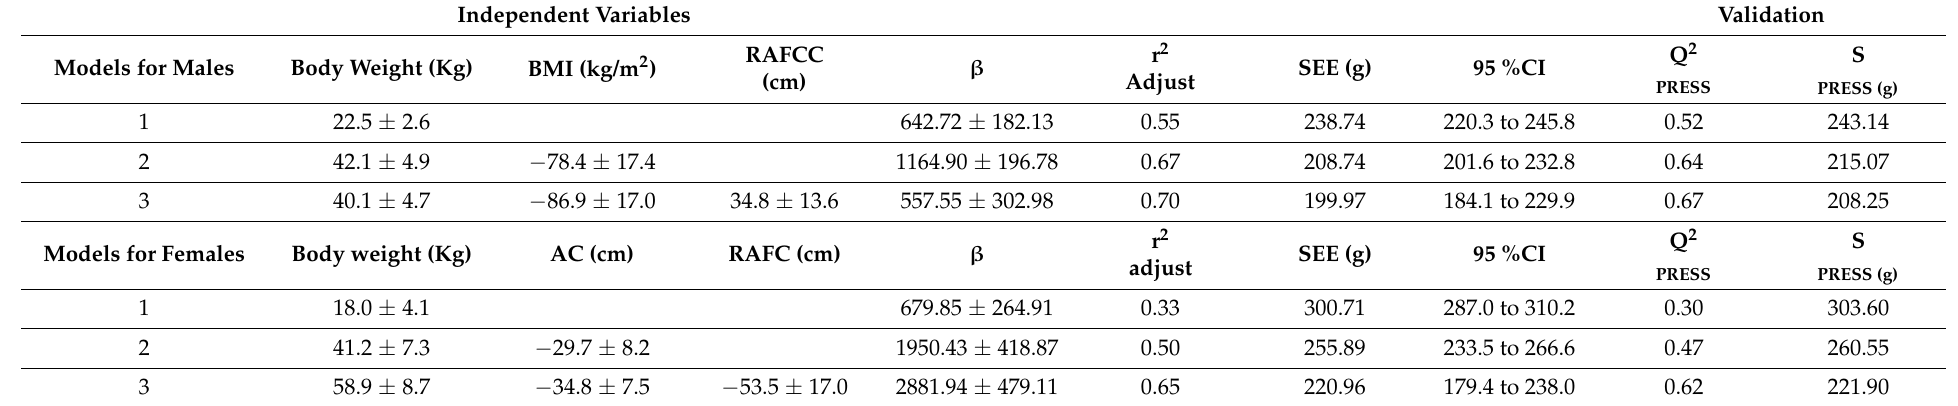
Table 2. Predictive models for bone mineral content (BMC) in 104 males and females living with HIV. Independent